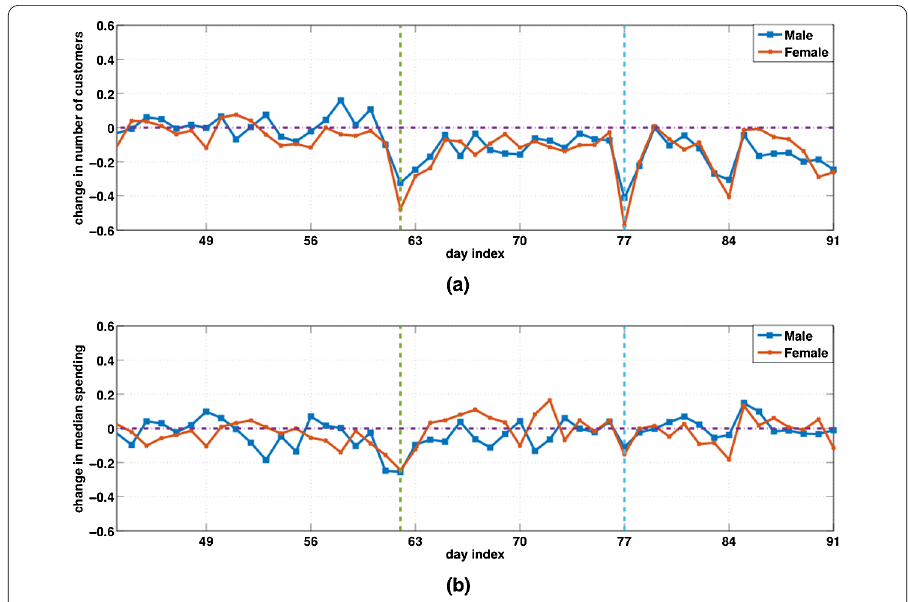
Figure 8 The impact of a series of protest events averaged over all neighborhoods for male (blue) and female (red) customers: ( a ) number of customers; ( b ) median spending. The dash-dot purple line indicates zero change, and the dashed green and cyan lines indicate Day 62 and Day 77, respectively